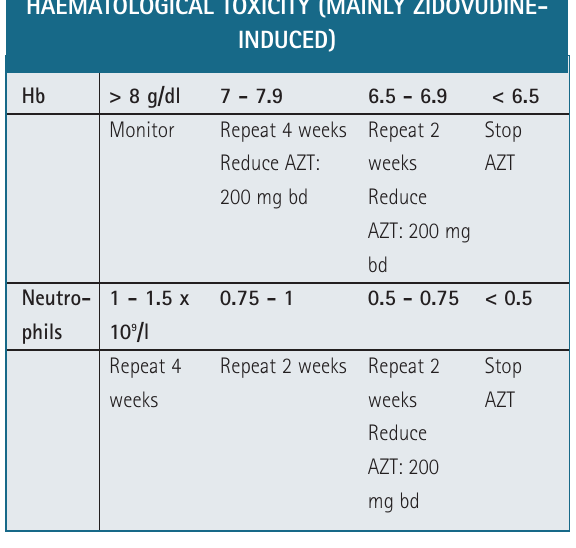
The potential of NRTIs to cause elevated lactate